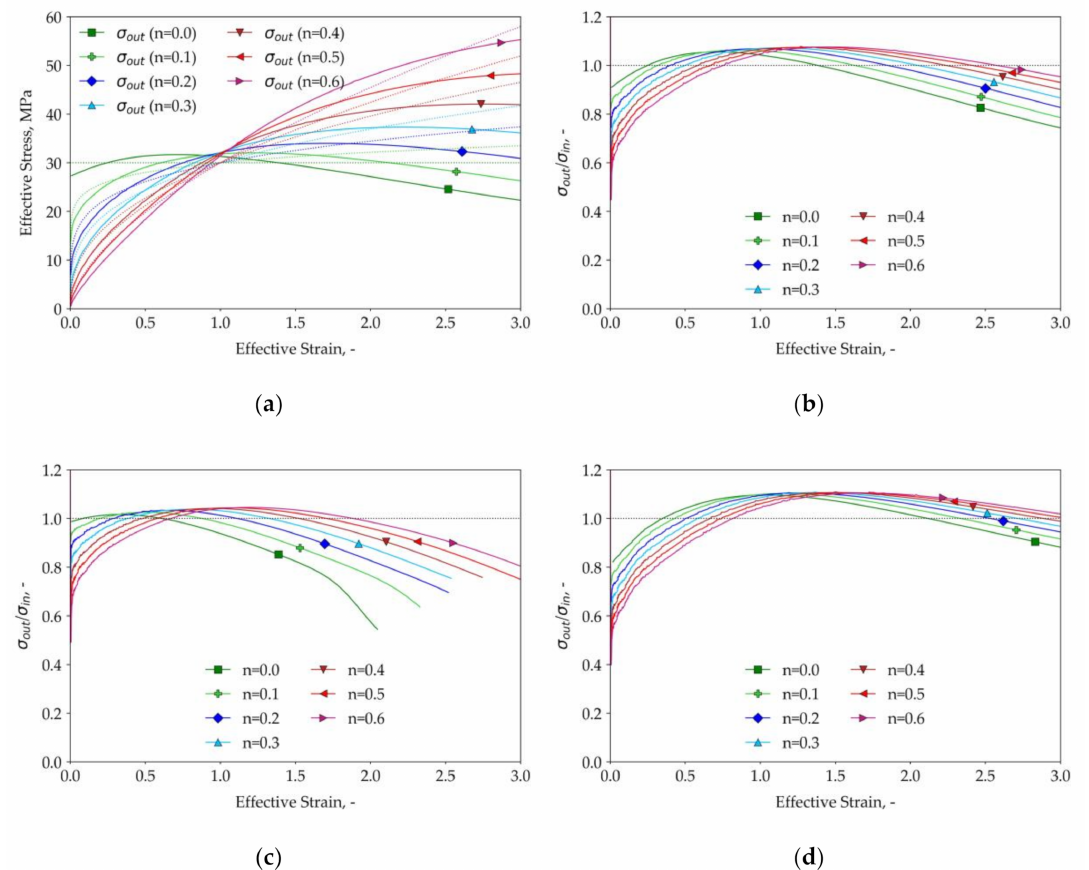
Figure 8. The e ff ect of strain hardening ( n ) on the results of tensile testing: ( a ) the stress–strain curves obtained for di ff erent n values at m = 0.5; ( b ) the normalized stress evolutions for m = 0.5; ( c ) the normalized stress evolutions for m = 0.3; ( d ) the normalized stress evolutions for m = 0.7. The output stress–strain curves obtained for m = 0.5 and di ff erent n values are plotted in Figure 8a by the solid lines. The dashed lines represent the input stress–strain relations. To study the di ff erence between the input and the output stresses, the evolutions of input to output stress ratios are presented in Figure 8b for the same m value. Figure 8c,d demonstrate the same results for the values of m equal to 0.3 and 0.7. As can be observed, the deviations between the input and the output stresses increase with strain hardening index. The moments corresponding to necking in Figure 8c are shifting to the right, demonstrating the increase in flow stability with the increase in strain hardening. The increase in strain hardening index results in the decrease in the normalized stress at the beginning of the test. The maximum value of the normalized stress is insignificantly a ff ected by the value of the strain hardening